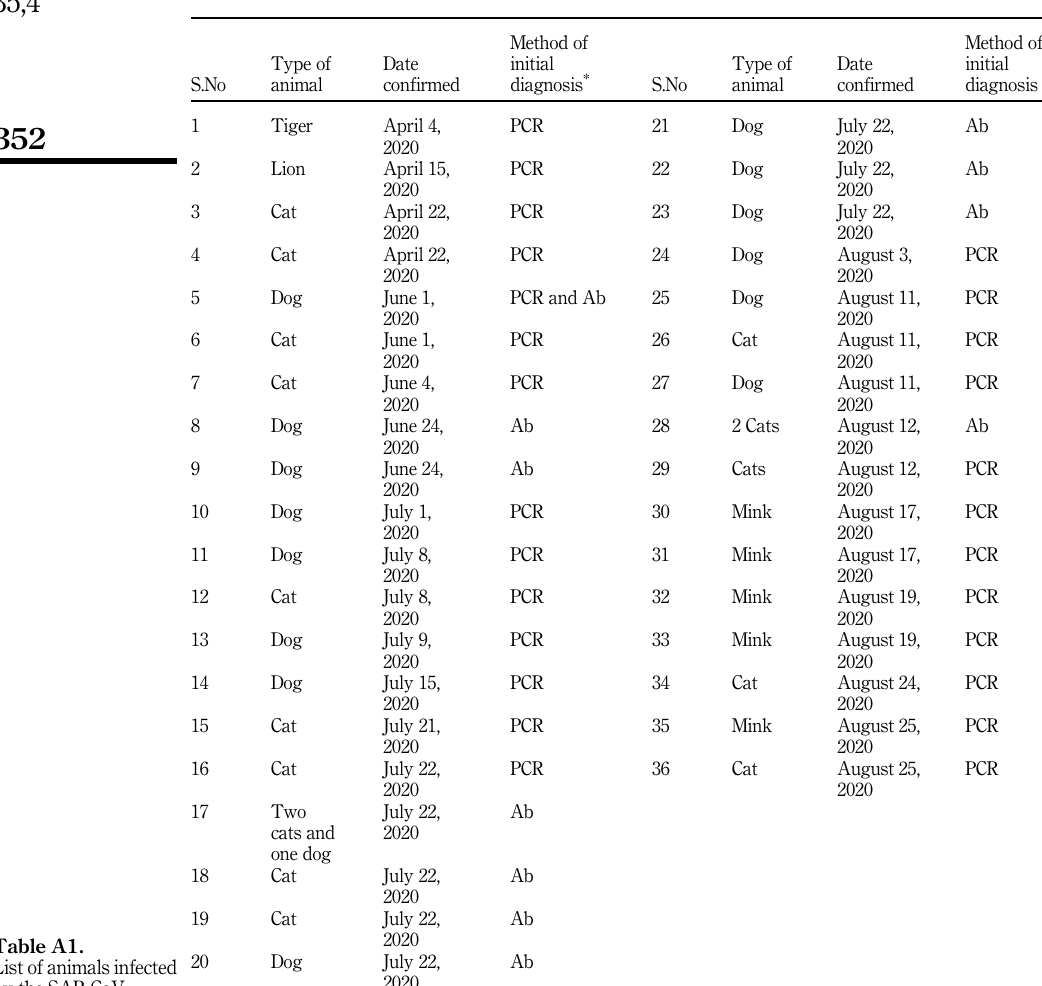
Table A1. List of animals infected by the SAR-CoV- 2